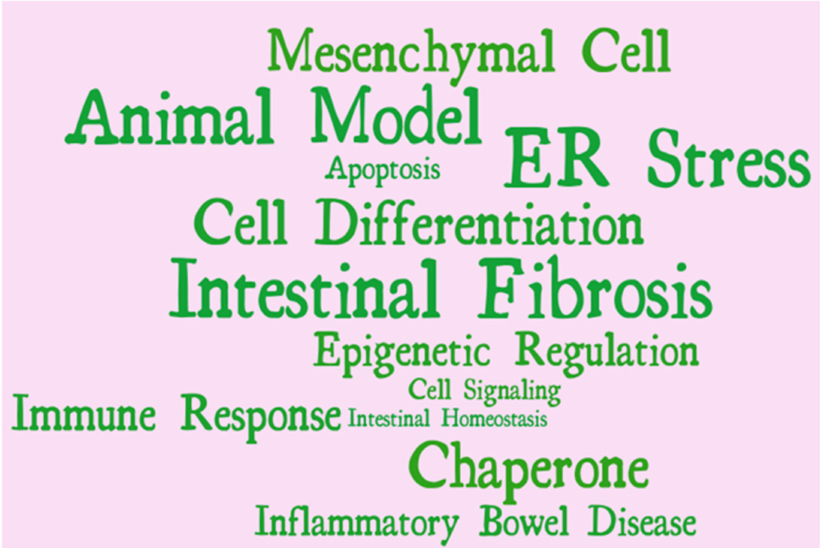
Figure 1. A word cloud of key concepts presented in this review is made by WordItOut online software.